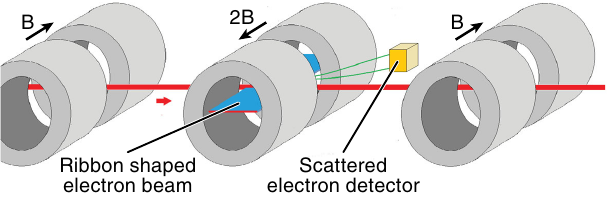
FIG. 22. Schematic illustration of a Coulomb scattering elec- tron wire beam profile monitor (see text).